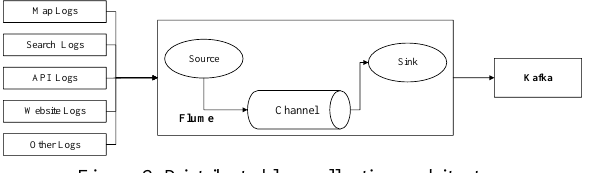
Figure 2. Distributed log collection architecture